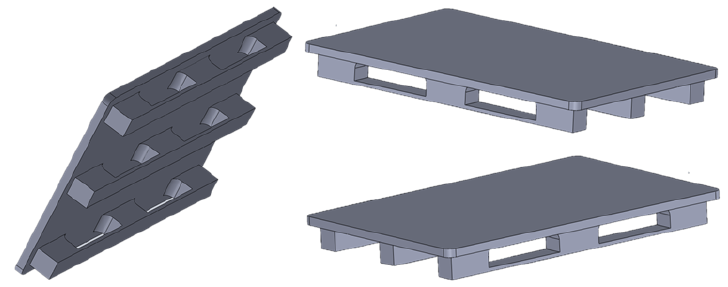
Figure 2. Standard EUR-pallet.